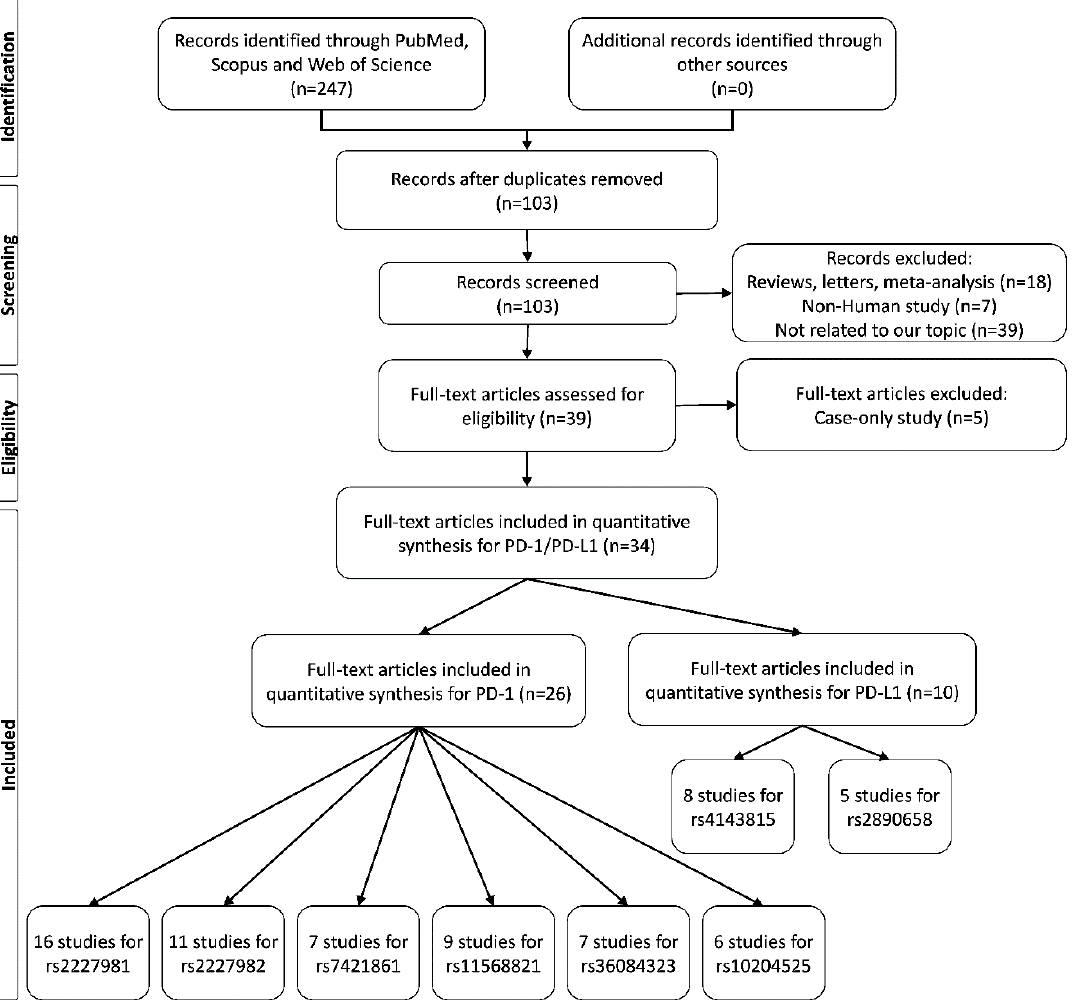
Figure 1. Flow diagram of study selection for this meta-analysis.